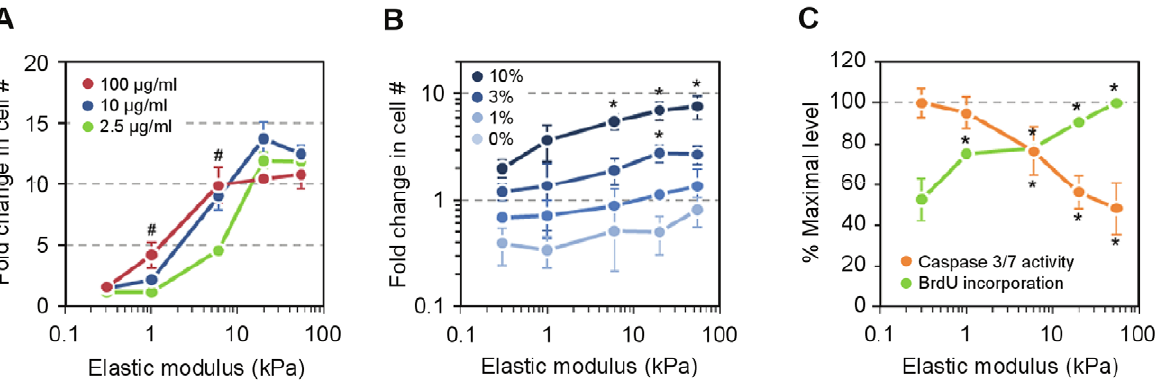
Figure 6. Substrate stiffness interactions with soluble and matrix factors. (A) Effect of varying collagen ligand density on cell accumulation. Applied collagen concentrations are indicated. Fold change represents number of attached cells at 72 h versus the 4 h attachment density. (B) NHLFs accumulate more rapidly on stiffer substrates in high serum concentrations. No significant differences in accumulation are detected in low serum concentrations, but both 0% and 1% conditions exhibit statistically positive trends with increasing stiffness (p=0.0032, p=0.013, respectively, by two-tailed t-test). (C) Increasing matrix stiffness promotes BrdU incorporation while suppressing caspase 3/7 activity in cells cultured in 10% serum. Values are normalized per cell number and expressed relative to the maximal value. Error bars indicate mean 6 SD (n=3). *p , 0.05 vs. effect on the softest substrate (0.3 kPa) by Tukey’s test. # p , 0.05 vs. effect at the lowest collagen density by t-test.